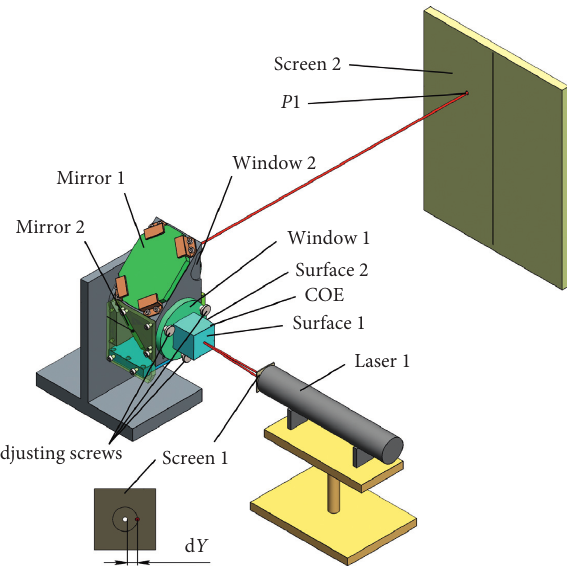
Figure 10: Adjustment of the TSM (Step